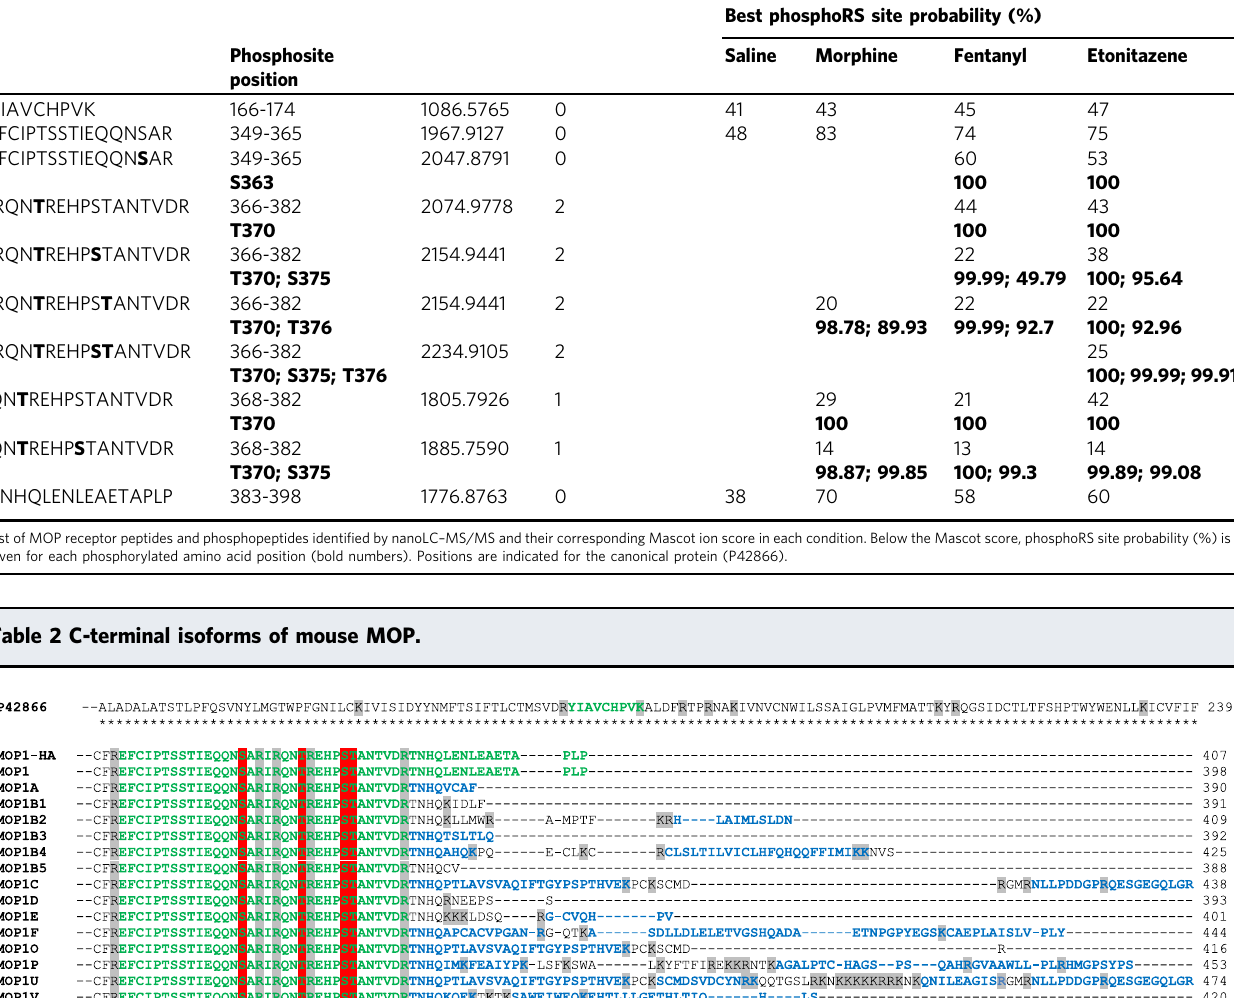
Table 1 MS analysis of agonist-induced phosphorylation sites in the MOP carboxy-terminus. Peptide sequence